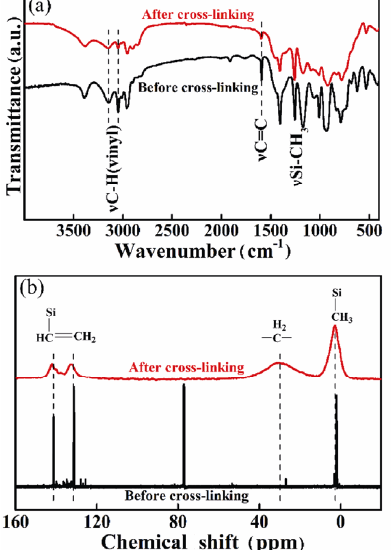
Fig. 3 (a) FT-IR spectra and (b) 13 C NMR spectra before cross-linking and 13 C( 1 H) CPMAS NMR spectra after cross-linking of PMVBSZ with DCP